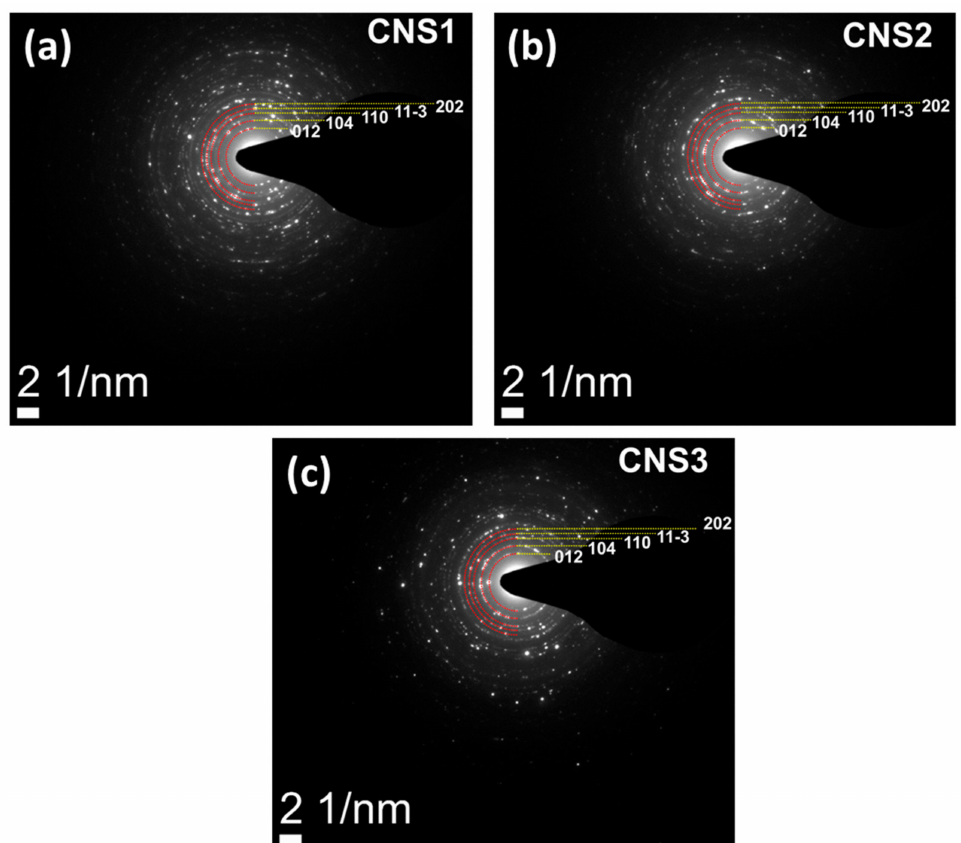
Figure 5. Selected area diffraction patterns of ( a ) CNS1, ( b ) CNS2, and ( c )